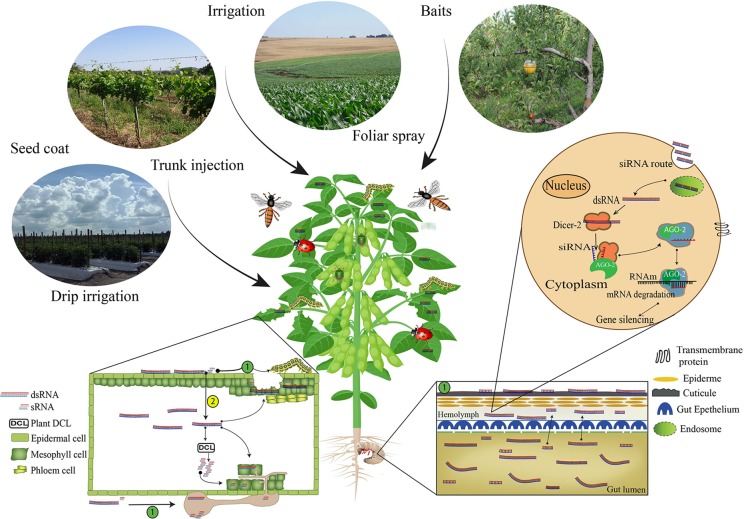
Non-transformative delivery strategy routes for RNAi-based gene silencing induction. The first step to achieve successful RNAi-based gene silencing results via non-transformative approaches is the selection of the RNAs (dsRNA or siRNA) delivery strategy: Foliar spray, trunk injection, irrigation, drip irrigation, seed coat, baits, and powder or granules for soil applications. Once the RNAs are delivered, the insects and pathogens need to internalize the RNAs molecules, and this process can occur (1) directly or (2) indirectly. The direct uptake occurs when the organisms get in contact with the RNAs molecules during application or feed on tissues containing the RNA molecules on the surface. However, when the RNA molecules are absorbed, translocated in the plant vascular system and taken up by the organism (Koch et al., 2016), the process is classified as indirect uptake (Cagliari et al., 2018). Inside the organism system, the cell uptake of dsRNA can be mediated by transmembrane channel proteins such as sid-1 (Feinberg and Hunter, 2003; Aronstein et al., 2006; Kobayashi et al., 2012) or endocytosis (Saleh et al., 2006; Ulvila et al., 2006; Cappelle et al., 2016; Pinheiro et al., 2018; Vélez and Fishilevich, 2018). The RNAi-based gene silencing depends on the release at cellular levels of dsRNA or siRNA molecules (Carthew, 2009; Zotti and Smagghe, 2015). When dsRNAs are unloaded in the cytoplasm, these molecules are processed into siRNA fragments by an enzyme called Dicer 2 (DCR-2) (Meister and Tuschl, 2004; Tomari et al., 2007). The siRNA fragments are then incorporated into the RISC complex (RNA-induced Silencing Complex), which contains the Argonaute 2 (AGO-2) protein (Matranga et al., 2005; Miyoshi et al., 2005; Ketting, 2011), and, in a sequence-specific manner, bind to a complementary messenger RNA (mRNA), cleave it, prevent protein formation (Agrawal et al., 2003; Huvenne and Smagghe, 2010), and thus affect target organism survival.